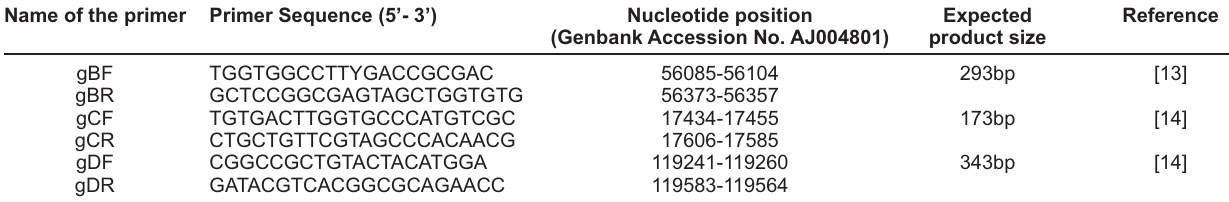
Table-1: Details of the primer used in the present study for molecular characterization of BHV-1 isolates. Name of the primer Primer Sequence (5’-